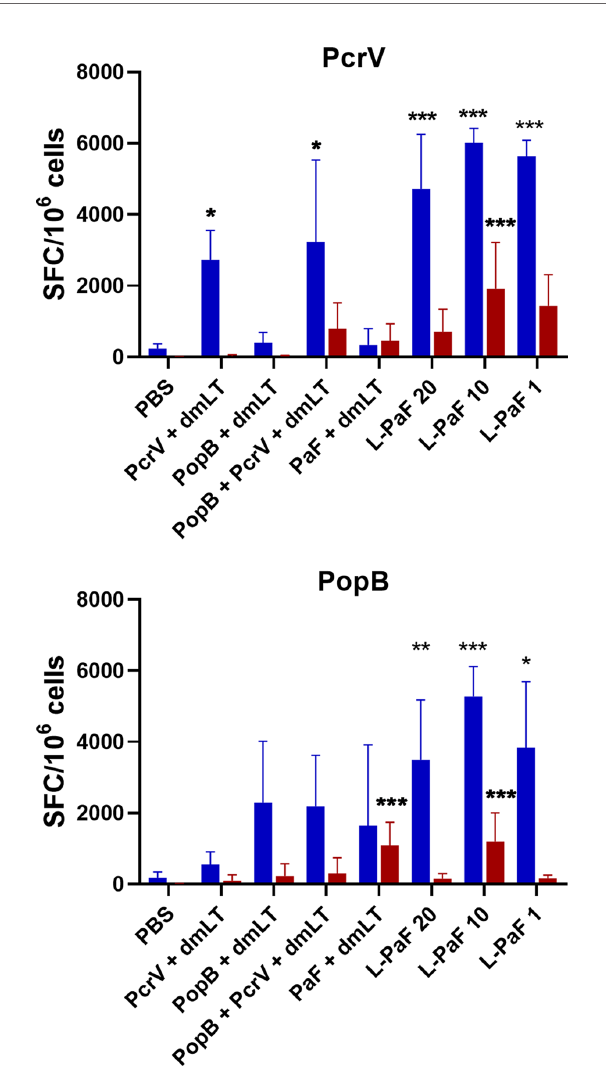
FIGURE 6 | Levels of IL-17 and IFN- g secreted from lung cells after stimulation with PcrV or PopB. The single lung cell suspensions from Figure 4 were used to assess antigen speci fi c IL-17 and IFN- g secretion from lung cell suspensions. Cells were incubated with 10 µg PcrV (top) or PopB (bottom). IL-17 (blue bars) and IFN- g (red bars) levels were determined by MesoScale Discovery analysis as per manufacturer ’ s speci fi cations and are presented here as pg/ml/10 6 cells. The data are plotted as means ± SD for individual mice in each group. Signi fi cance was calculated by comparing groups that were unvaccinated (PBS) and mice vaccinated with antigens using two-way ANOVA. *p < 0.05; **p < 0.01; ***p <